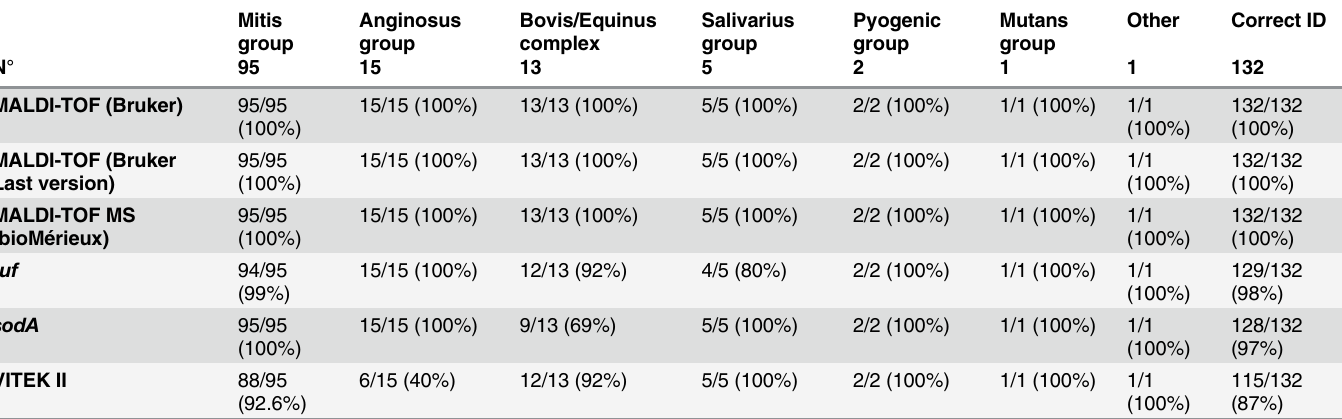
Table 3. Non pneumococcal VGS isolates MALDI-TOF, VITEK II, soda and tuf identi fi cation versus rpoB genes sequencing: group